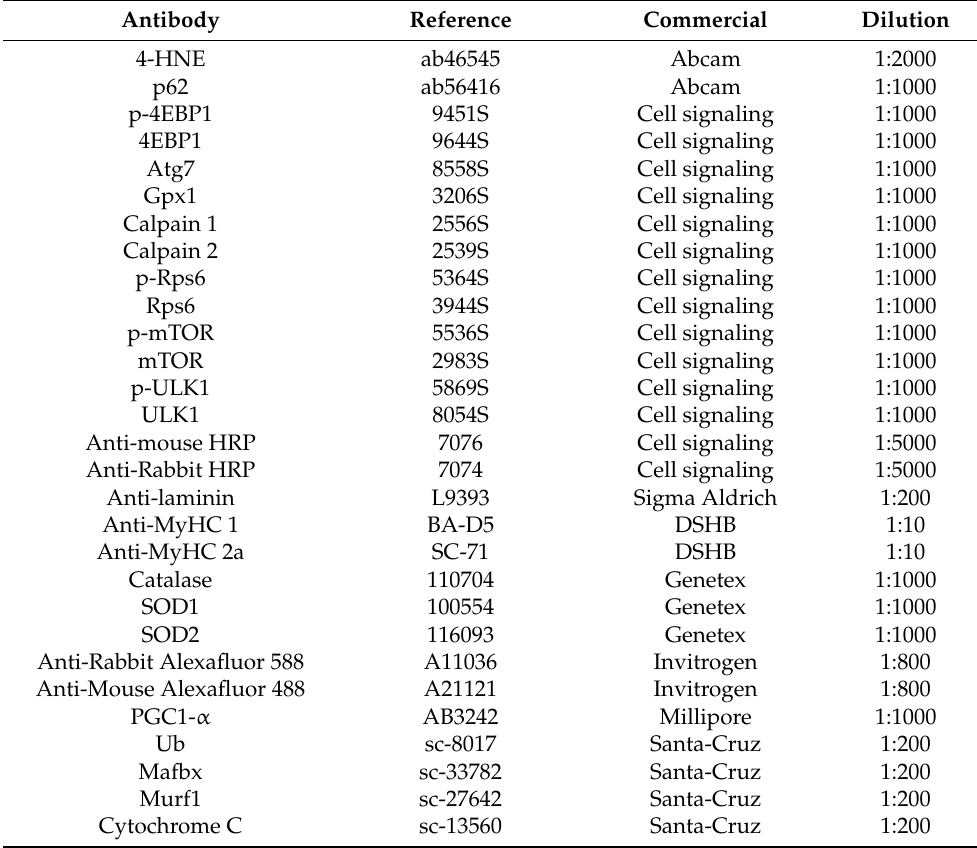
Table 2. Antibody